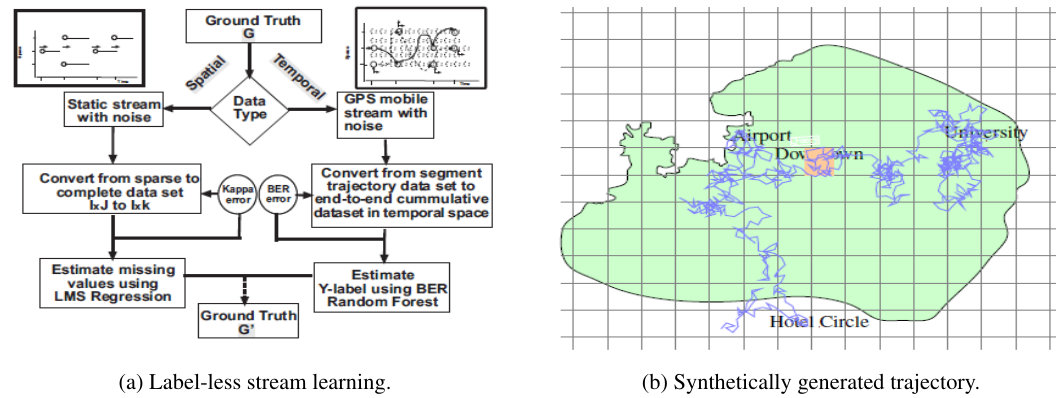
Fig. 2 The prototype of rare event learning functions using distance and similarity of sensor streams produced by trajectory being cross-validated with ground truth for stream